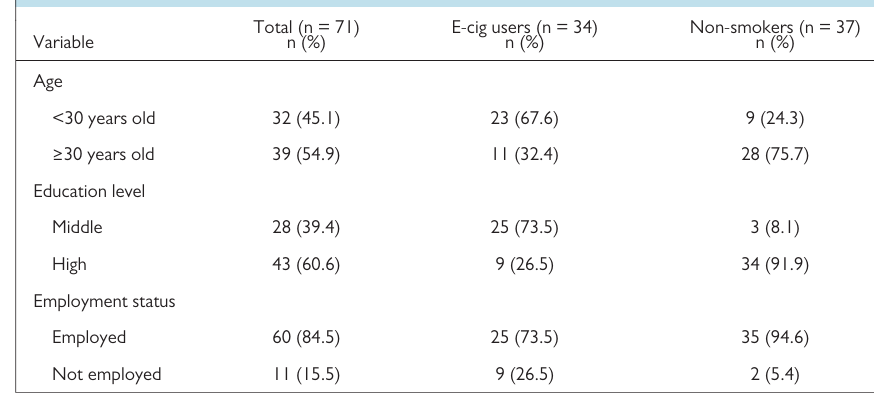
Table 1. Characteristics of